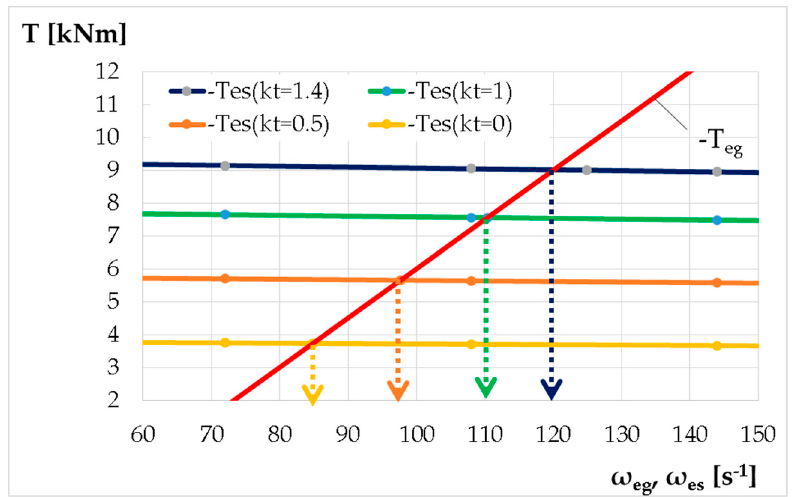
Figure 8. Graphical determination of the running point parameters on the equivalent output shaft for the four analyzed cases ( k t = 0; 0.5; 1; 1.4).